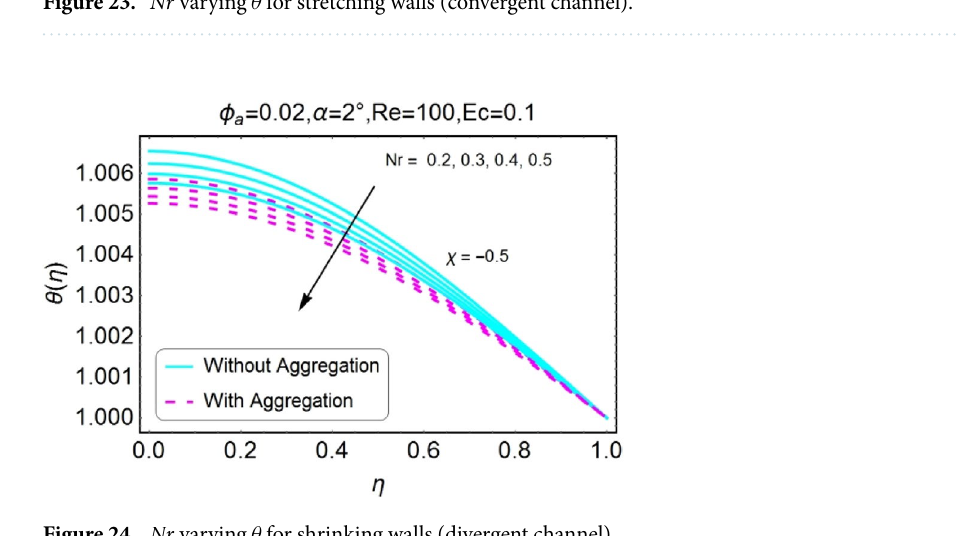
Figure 24. Nr varying θ for shrinking walls (divergent